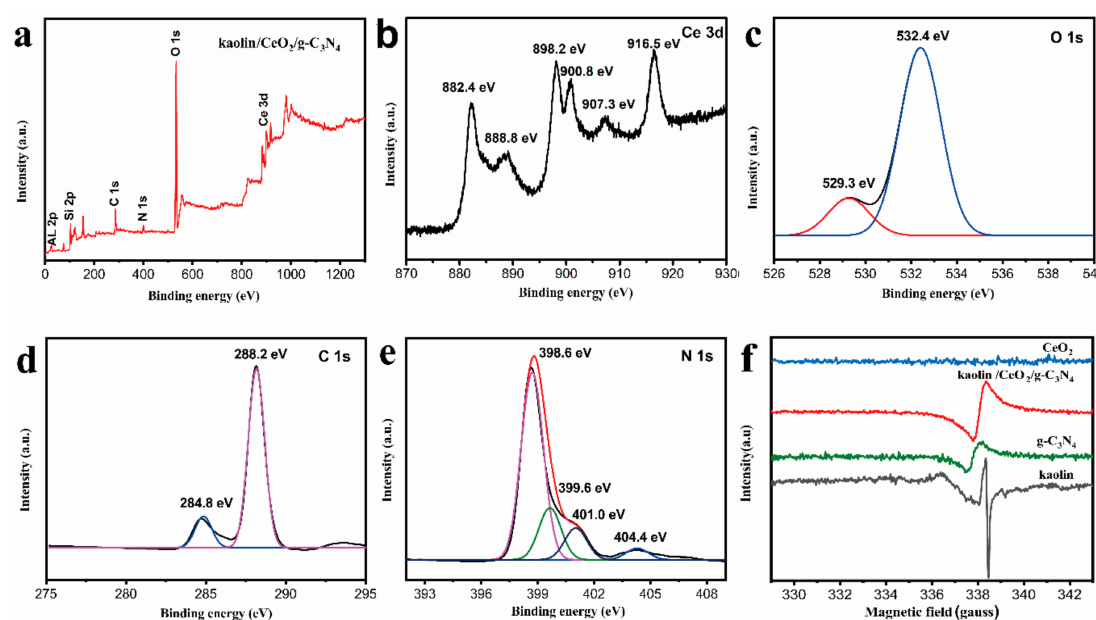
Figure 2. ( a ) XPS spectrum of kaolin / CeO 2 / g-C 3 N 4 composite, ( b ) Ce 3d, ( c ) O 1s, ( d ) C 1s and ( e ) N 1s ( f ) The EPR signals of CeO 2 , kaolin / CeO 2 / g-C 3 N 4 , g-C 3 N 4 and